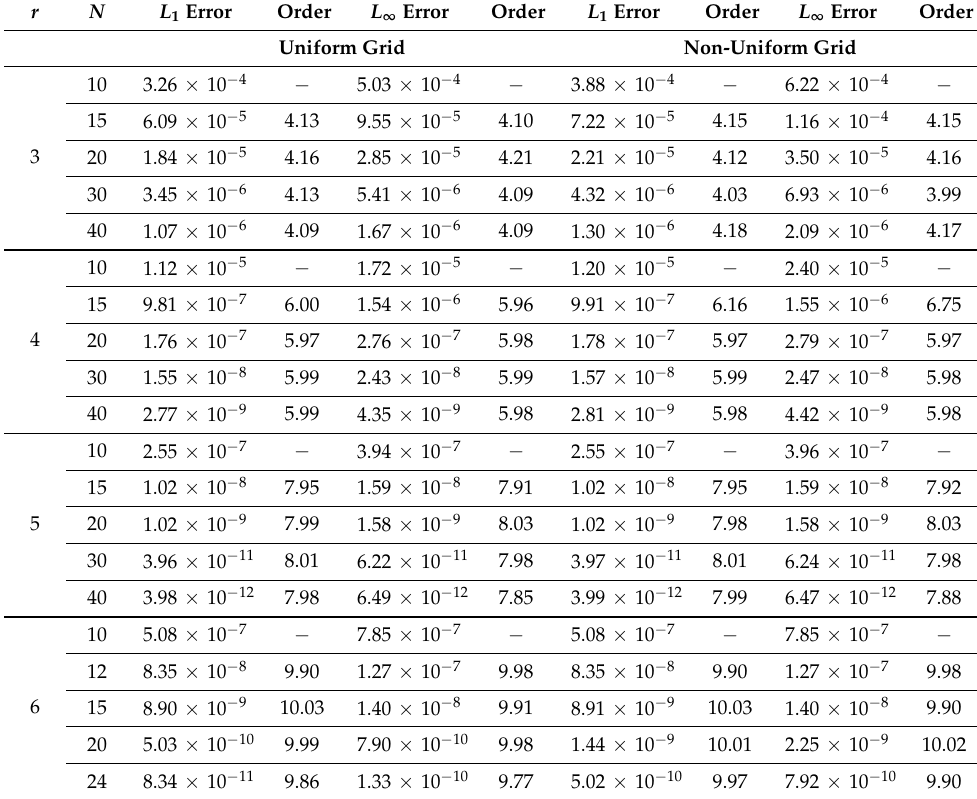
Table 3. Accuracy test for the one-dimensional Euler equation with u ( x ,0 ) = 0.5 + sin ( x ) at t = 2 π